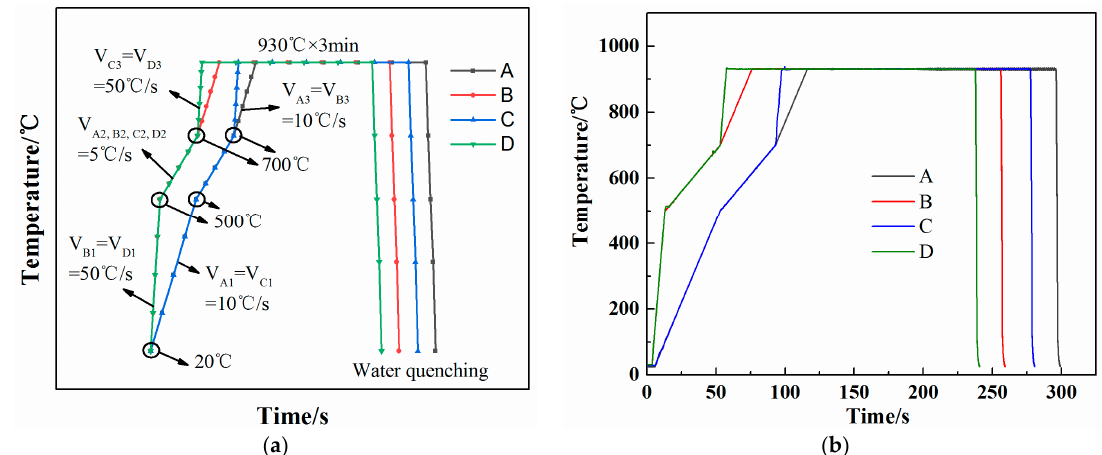
Figure 8. Three-step heating methods of ( a ) theoretical thermal history and ( b ) actual thermal history.